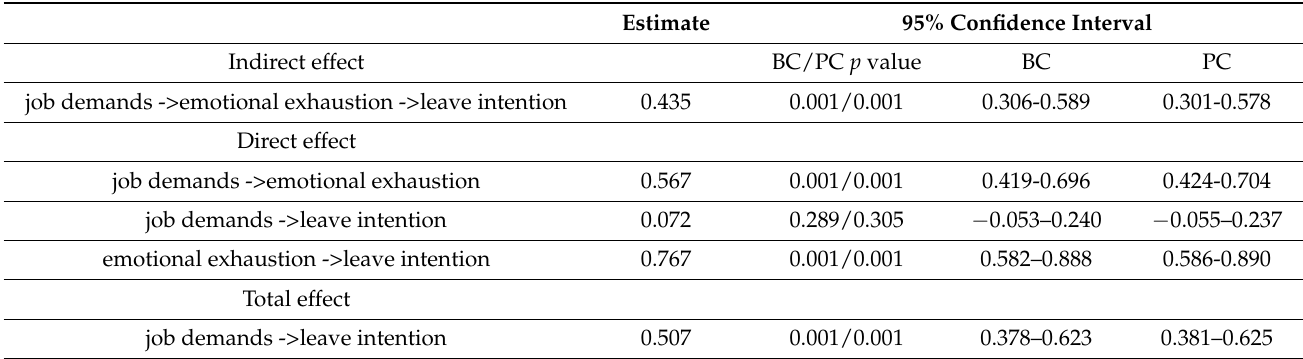
Table 8. Summary of Mediating